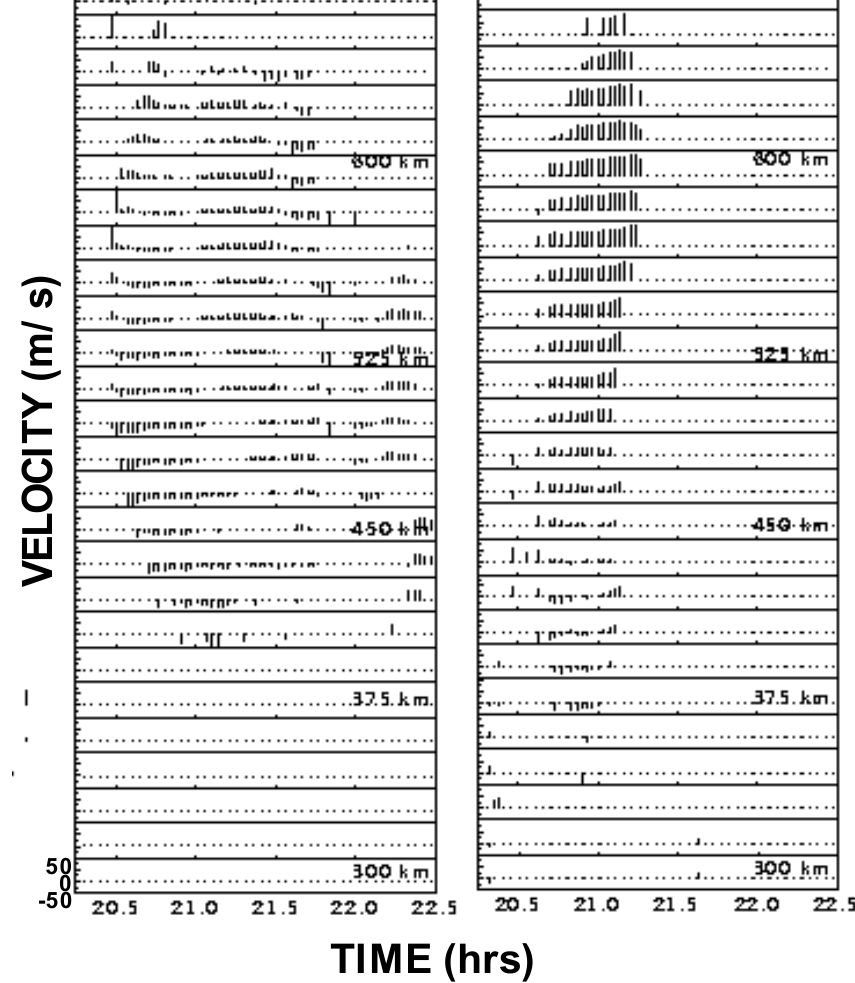
Fig. 6. The RTV plots of HF radar returns from the spread-F irregularities of 8.3-meter scale size observed on 10 and 11 August 1999.